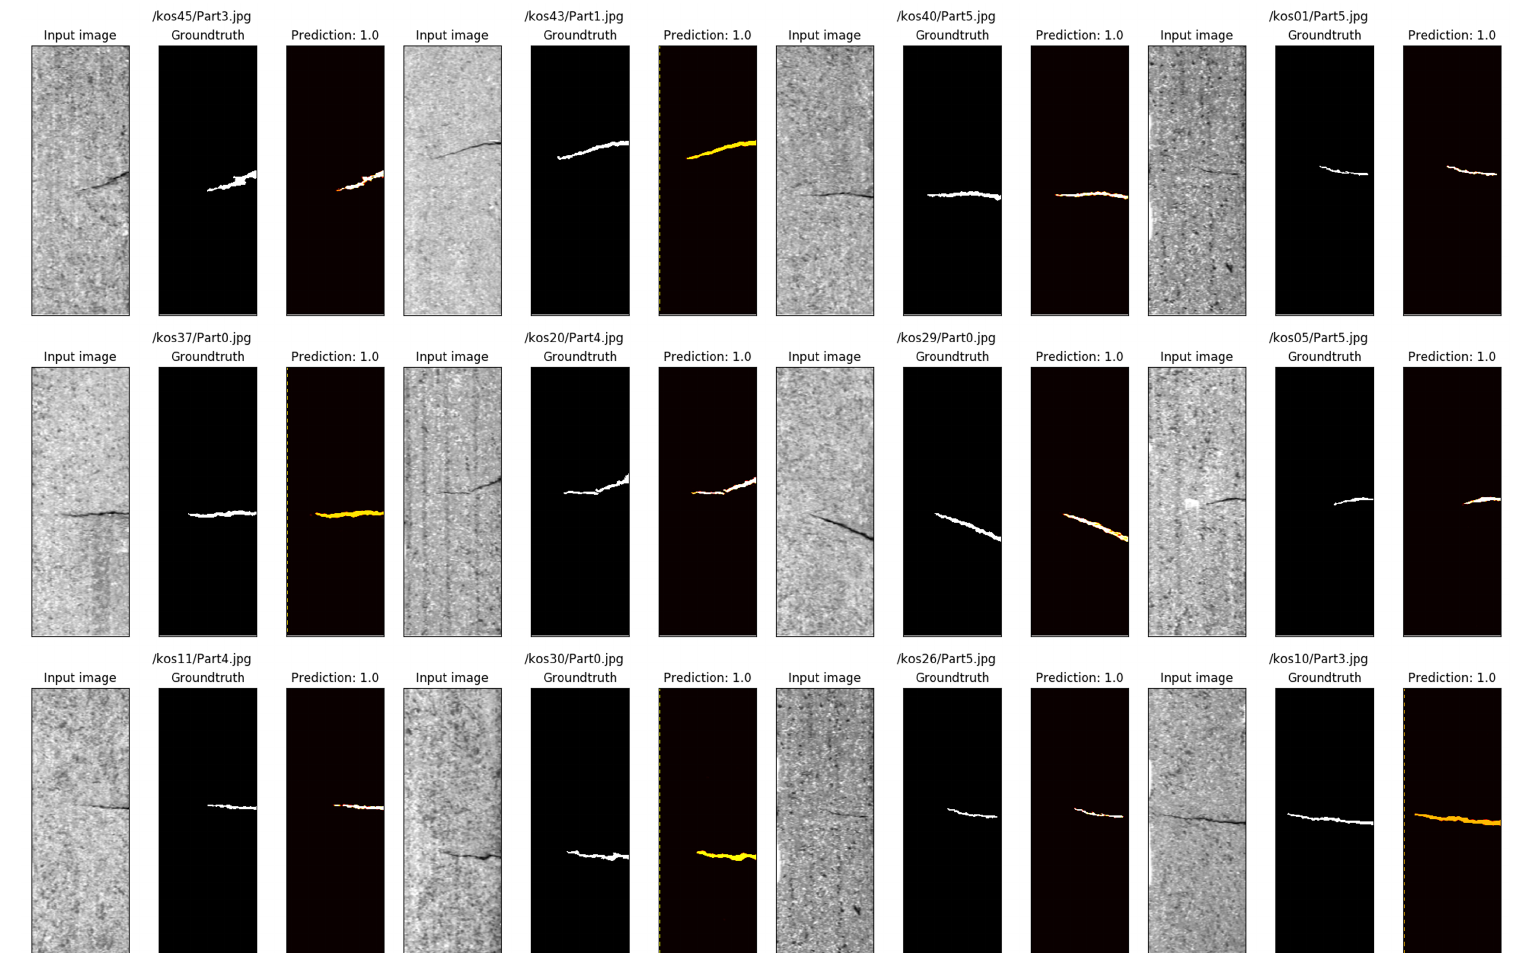
Figure 10. Examples of KolektorSDD defect segmentation